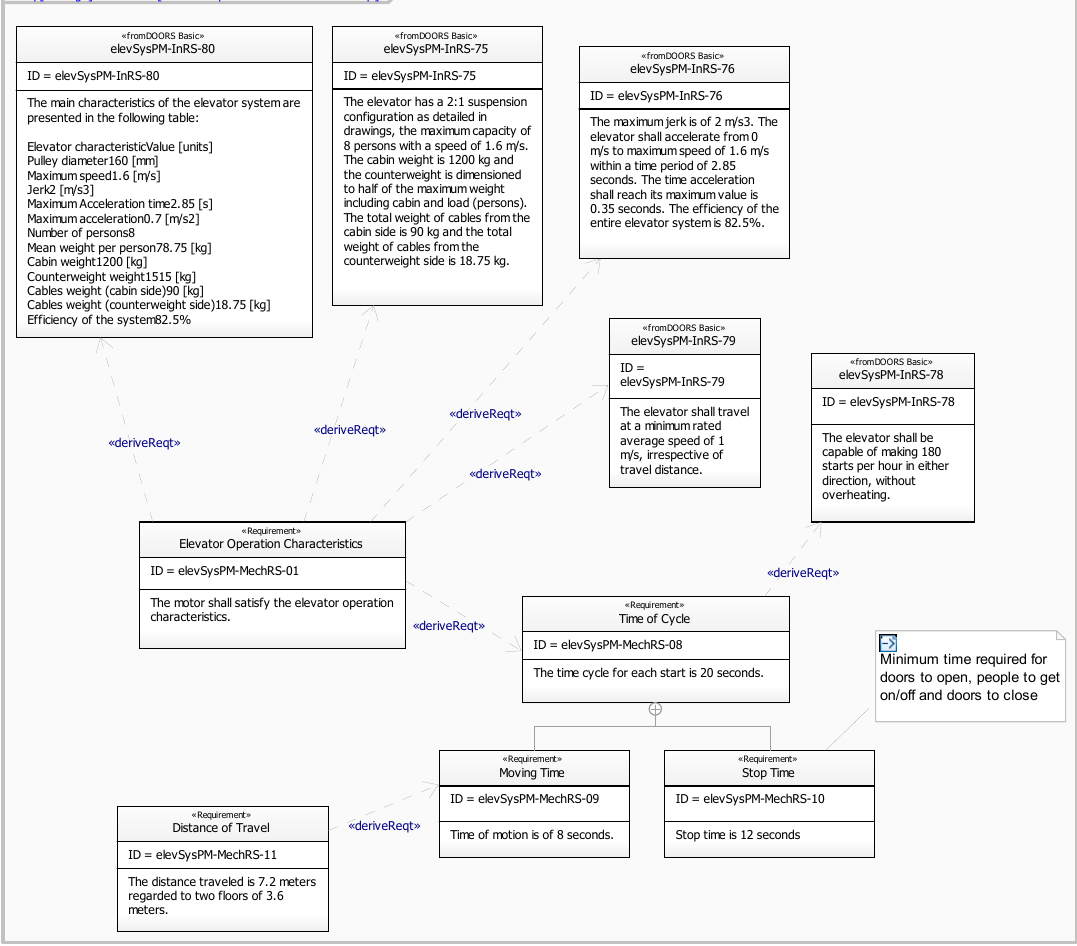
Figure 12. Mechanical requirements derivation.